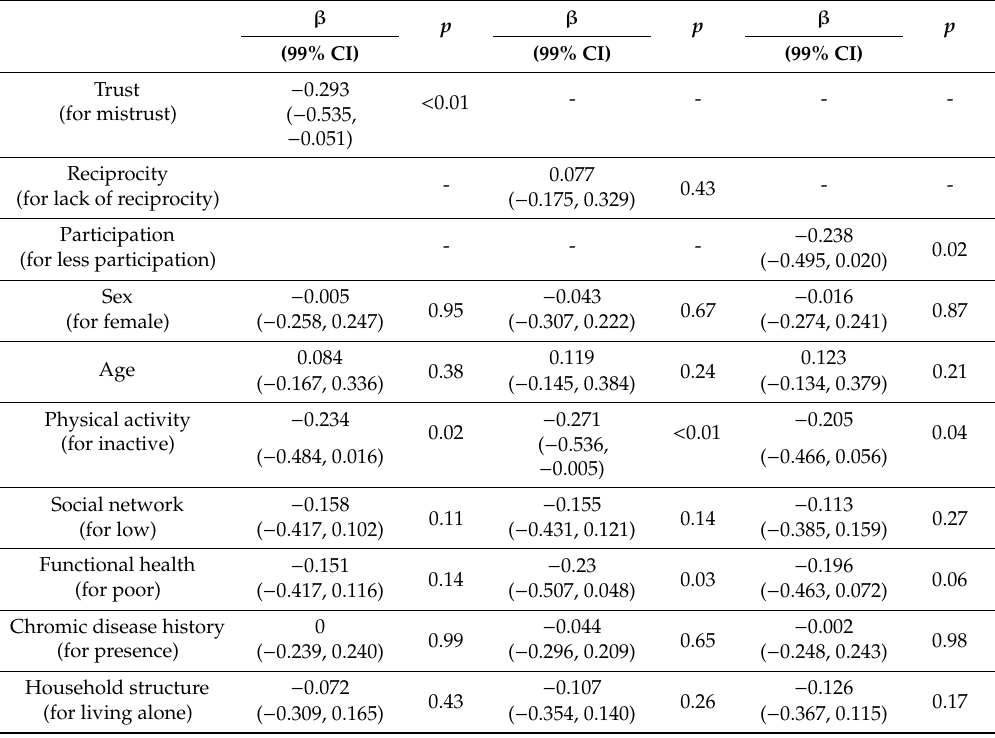
Table 4. The association between social capital and low SWB (RPH group; n = 101).